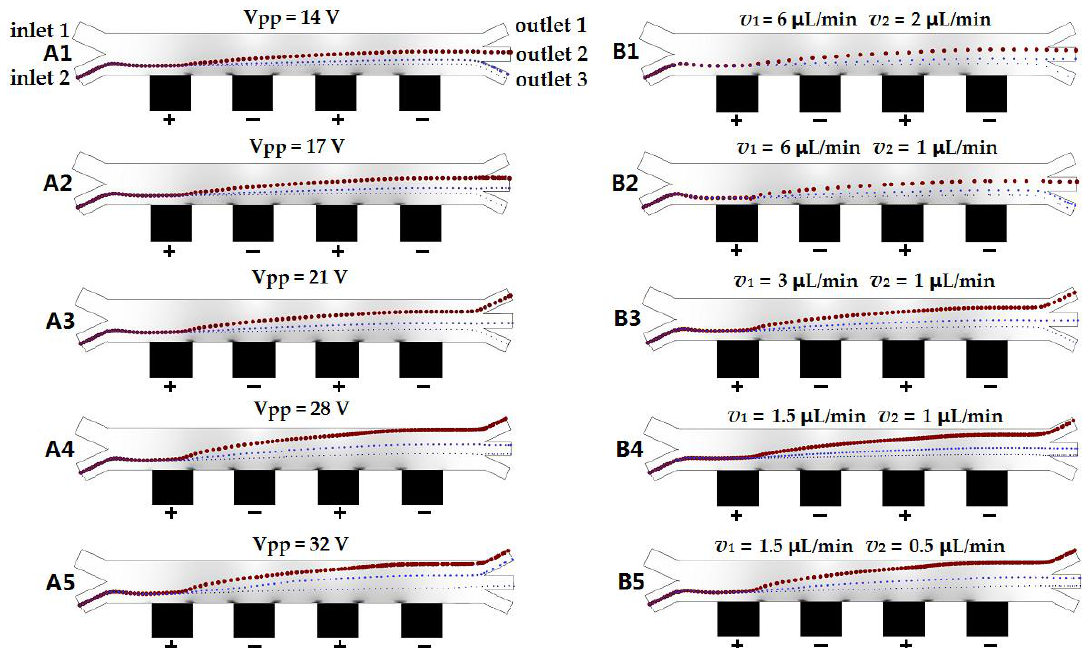
Figure 4. ( A1 – A5 ) Numerical simulation for the e ff ect of changing the peak-to-peak voltage (Vpp) of the separation signal on the separation results at fixed flow rates of v 1 = 3 µ L / min and v 2 = 1 µ L / min. ( B1 – B5 ) Numerical simulation for the e ff ects of the flow rate and the ratio of the flow rates at the two inlets on the separation at a fixed peak-to-peak voltage of 20 V.